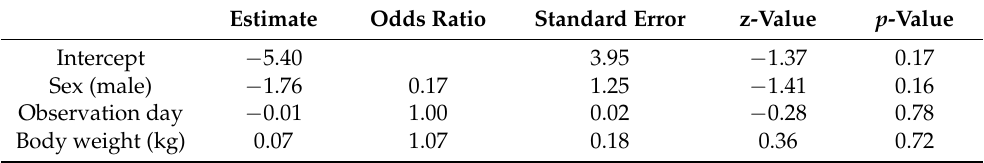
Table 5. Results of the logistic regression model for urination.